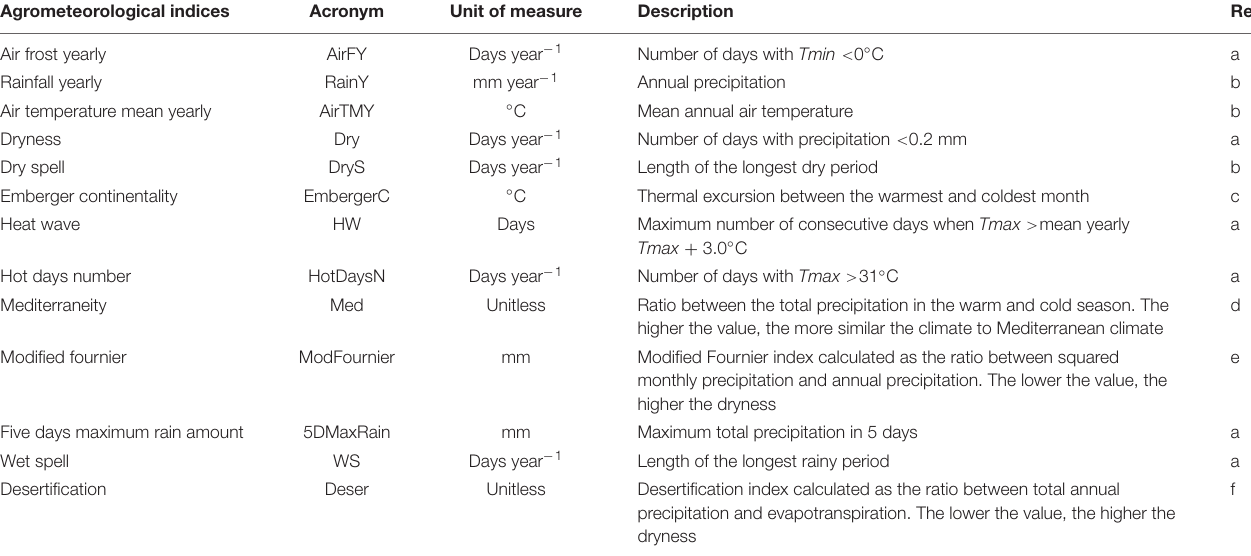
TABLE 1 | Agrometeorological indices computed on historical weather time series (1984–2018) in the Turkish hazelnut growing area. Agrometeorological indices